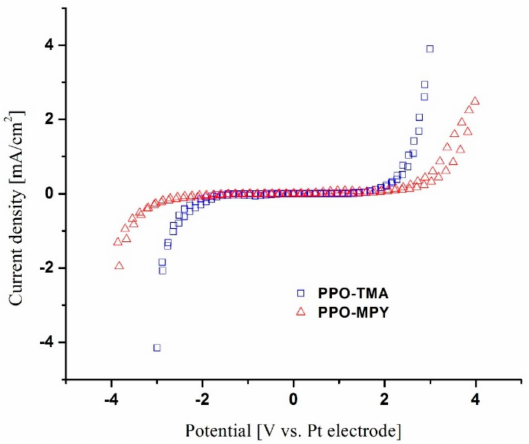
Figure 7. Cyclic voltammograms of PPO–TMA and